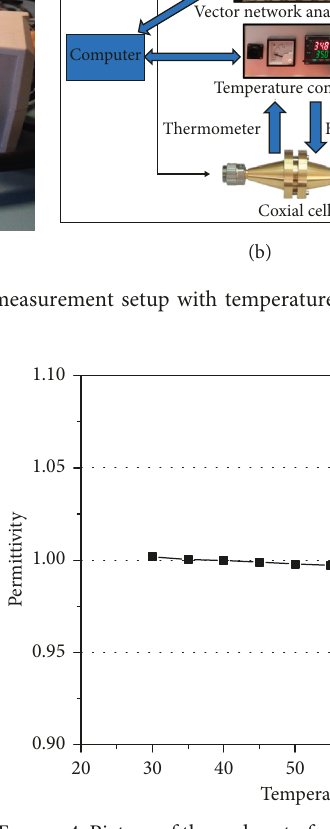
Figure 4: Picture of the real part of permittivity of air for an empty cell as a function of temperature at